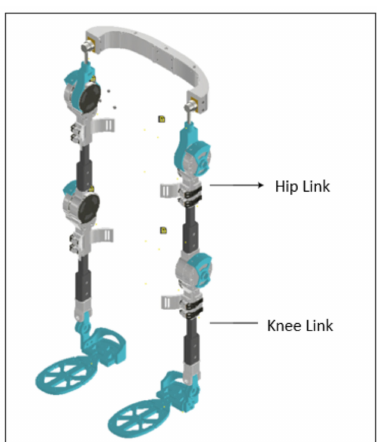
Figure 7. Exoskeleton